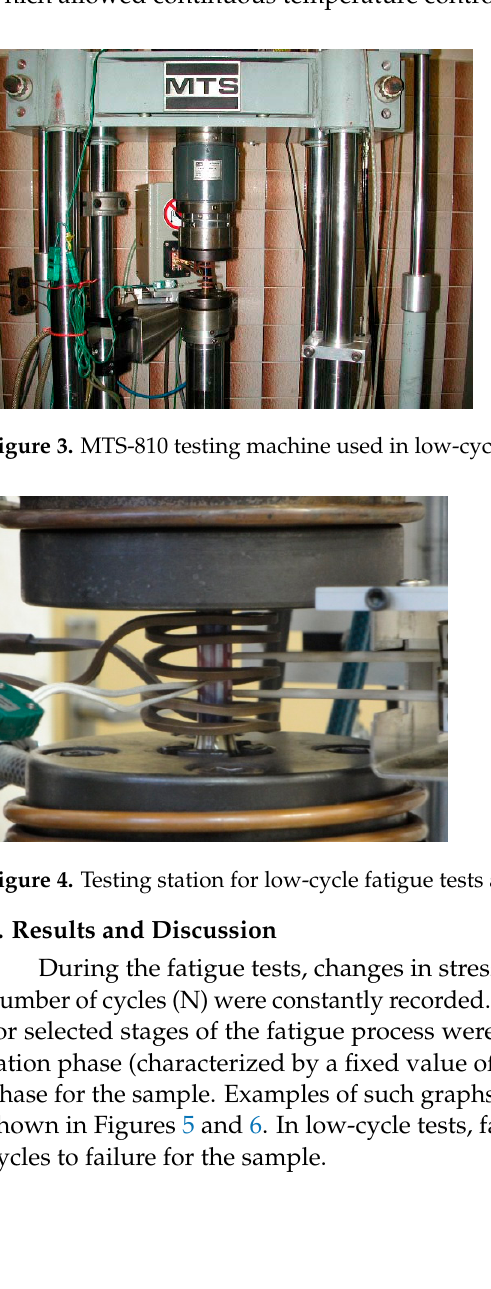
Table 1. Mechanical properties of the HR6W alloy obtained at room temperature and 650 °C.